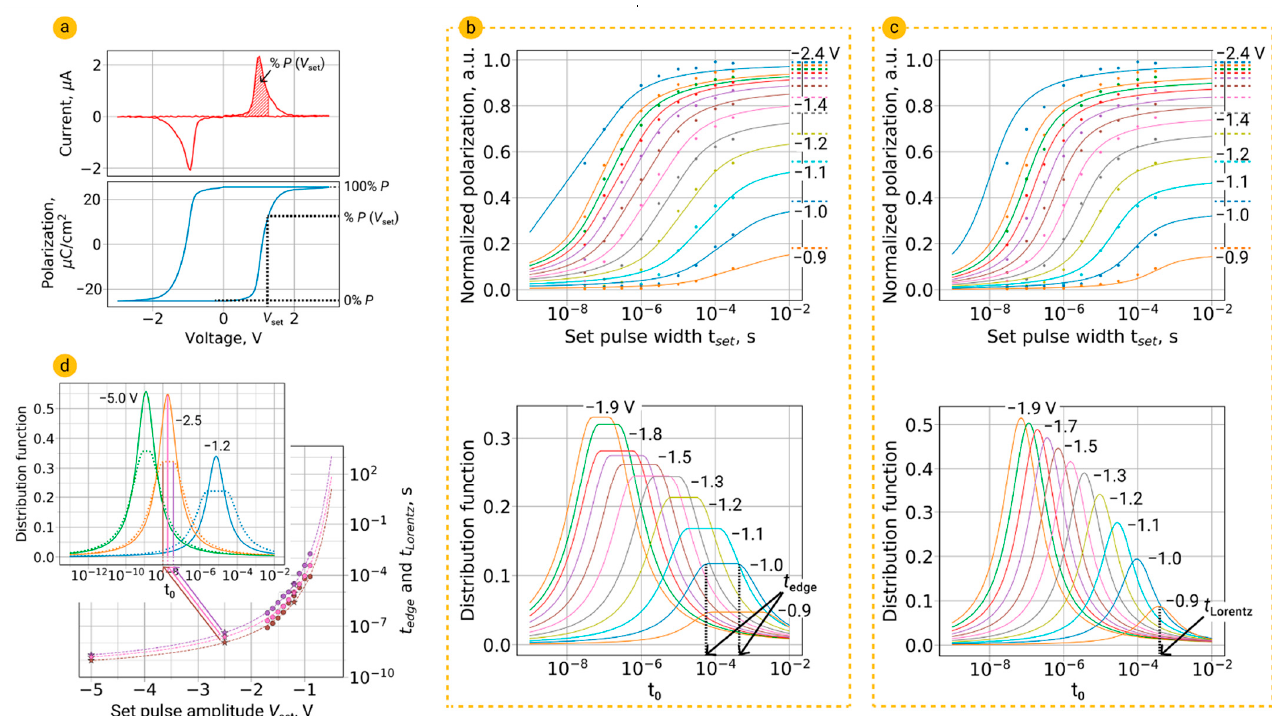
Figure 2. Examination of NLS model with flat and Lorentzian distributions of switching times. ( a ) Switching I–V and P–V curves. ( b ) Result of fitting by the NLS model with a set limit on the maximal switching by each voltage; distributions of log t 0 . Dotted lines notate maximal possible switching polarization for different V set . ( c ) Result of fitting by the NLS model with the Lorentzian distribution of switching times (with a set limit on the maximal switching by each voltage); Lorentzian distributions of log t 0 . ( d ) Comparison of the voltage dependences of the t left (brown) and t right (lilac) and t Lorentz (pink). The inset shows the positions of the predicted peaks of both kinds of distributions for unknown voltages.